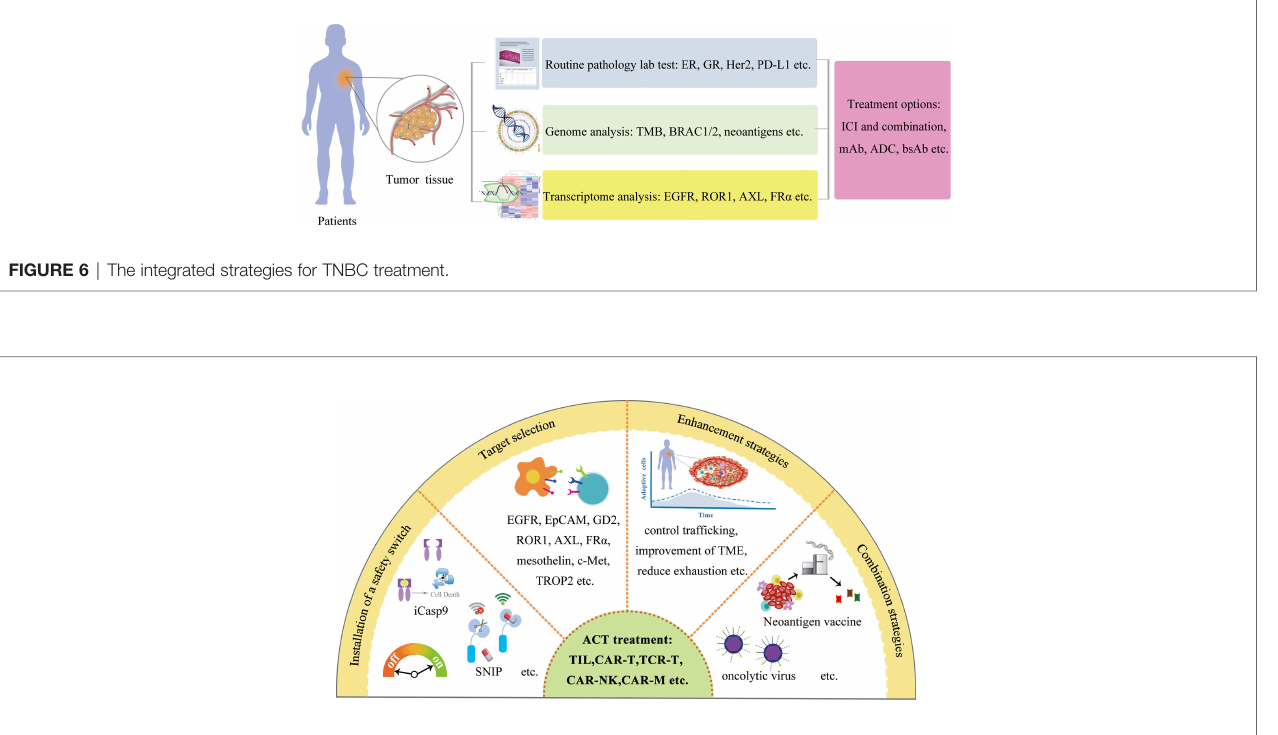
FIGURE 7 | The improvements of ACT for TNBC treatment.